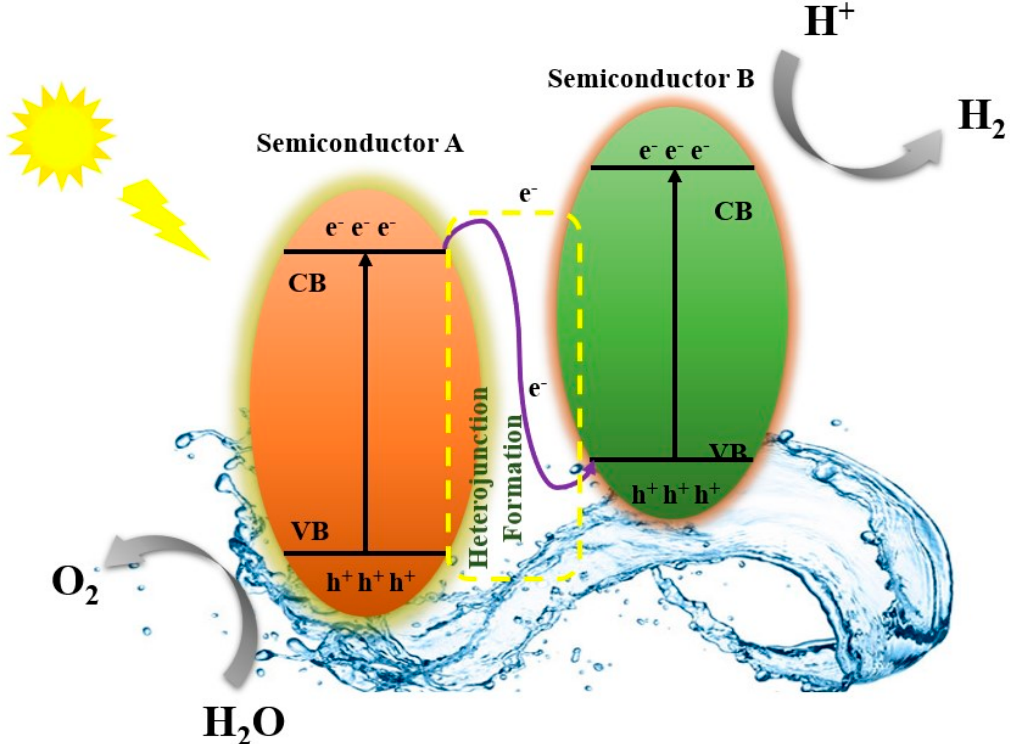
Figure 2. Schematic diagram of two different semiconductors showing heterojunction formation.